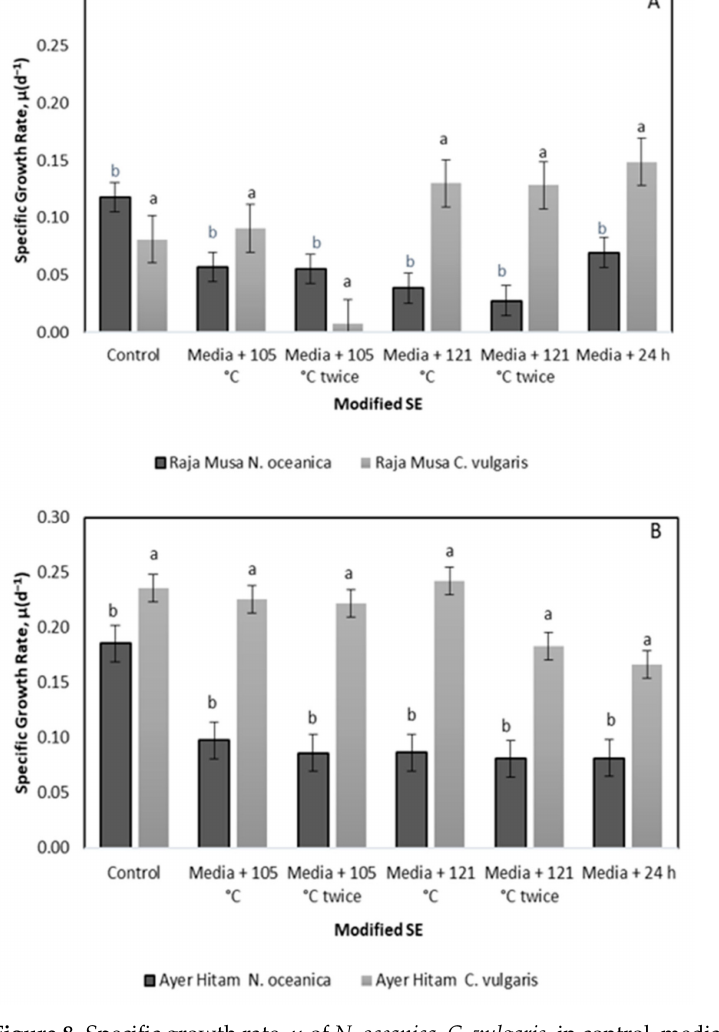
Figure 8. Specific growth rate, µ of N. oceanica, C. vulgaris, in control, media + 105 ◦ C, media + 105 ◦